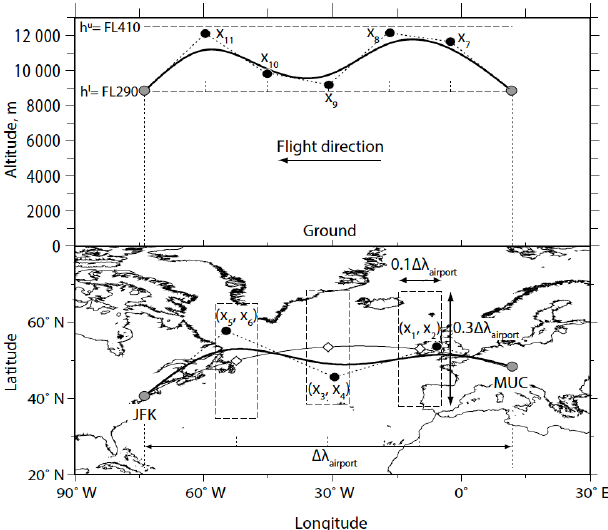
Figure 4. The geometry definition of a flight trajectory with the vertical cross section ( top ) and horizontal cross section ( bottom ) reprinted from [44]. The bold solid line indicates the real trajectory from MUC to JFK. The black dots are control points determined by design variables x i . The cruise flight altitude is allowed to vary from 29,000 feet (FL290) to 41,000 feet (FL410). Bottom: the dashed boxes show rectangular domains of three control points. The diamonds along the great circle are centre points of the boxes. ∆ λ airport is the longitudinal distance between two